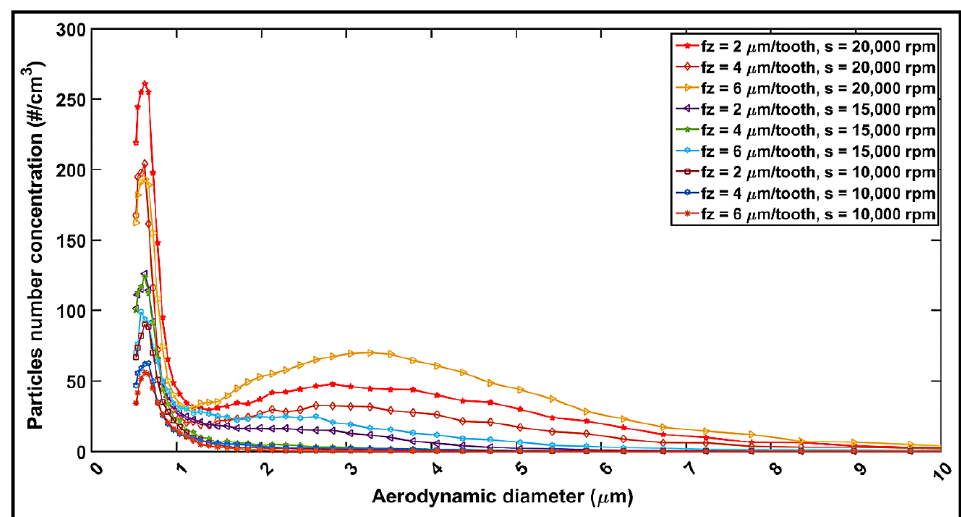
Figure 9. Number of fine particles vs. particle size during milling of CFRP for different cutting conditions.